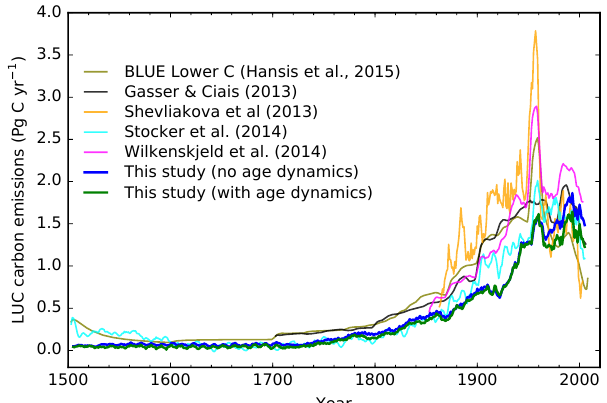
Figure 1. Annual carbon emissions from historical land use change over the globe by our studies and from other previous studies. Re- sults of this study are smoothed using a 10-year average moving window; data of other studies are from Fig. 5 (Hansis et al., 2015) and are smoothed using a 5-year moving average